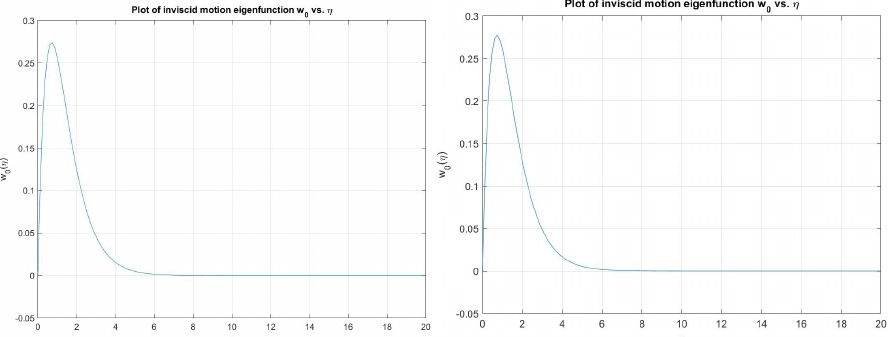
Figure 8. Plot showing the inviscid motion eigenfunction w 0 against η for ψ = 90, T s = 0.30 ( left ) and 0.65 ( right ).